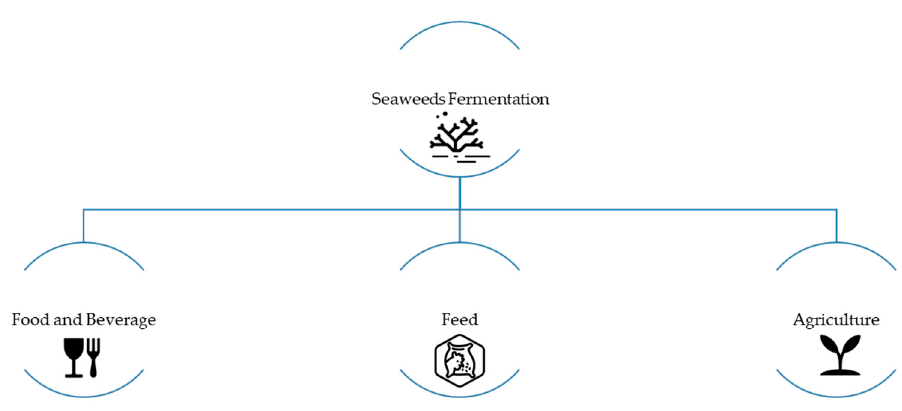
Figure 2. Schematic representation of seaweed fermentation biotechnological